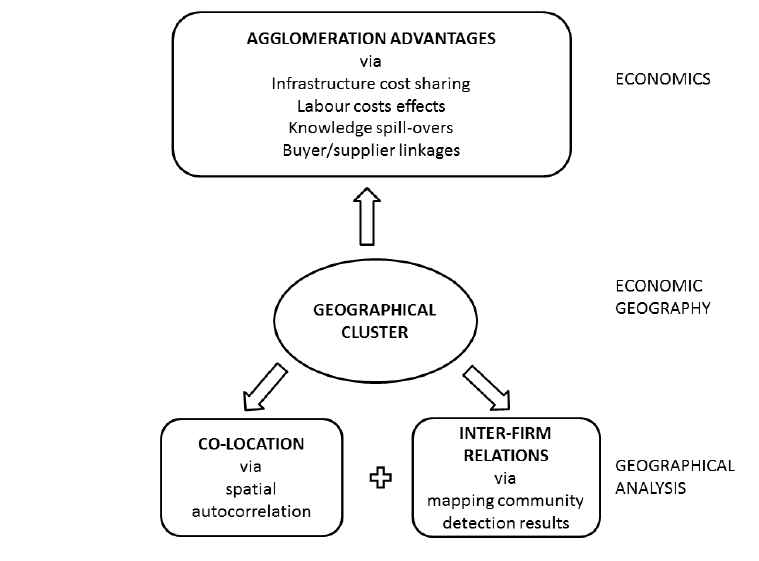
Figure 1. Conceptual